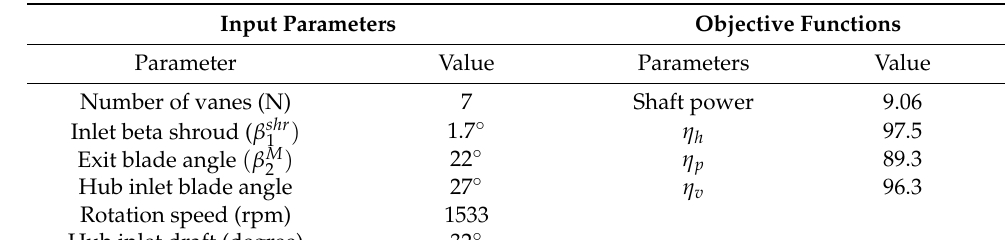
Figure 4. Variation of pump power with rotational speed and blade angle beta. Table 6. Parameters obtained for optimized impeller geometry.